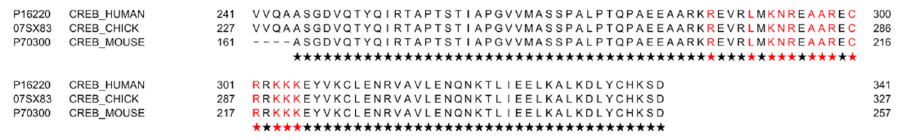
Figure 2. Alignment of cAMP response element-binding protein (CREB) protein sequences from human, mouse, and chicken origin. Stars indicate fully conserved amino acids. The amino acids in red indicate the DNA binding sequence.